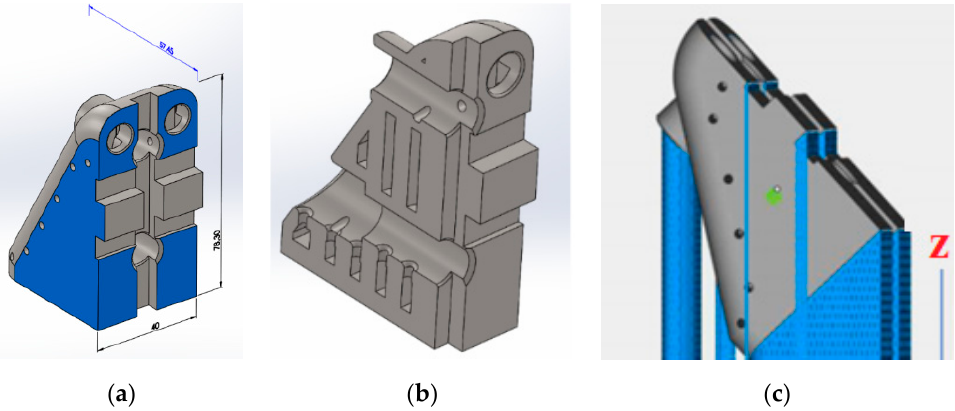
Figure 2. Jaws sample: ( a ) model dimension, ( b ) cross section, and ( c ) samples with support material.